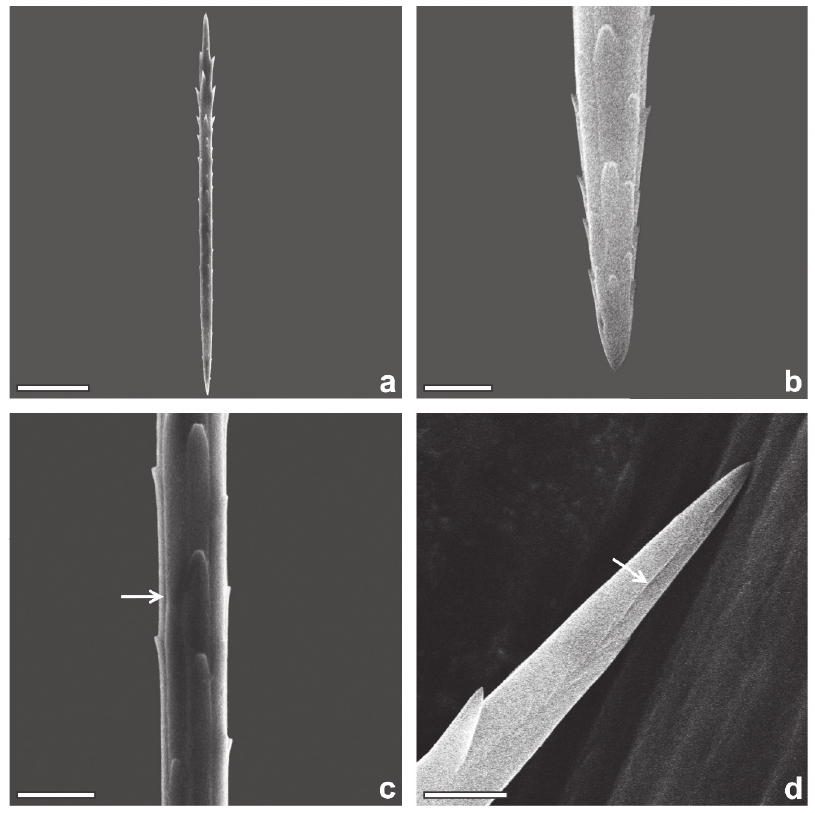
Figure 3 - True setae of the female H. oratex . (a) general view; (b) base; (c) medial portion, arrow indicates a longitudinal groove; (d) apex, arrow indicates the apical groove (scales = 25, 03, 05, 05 µm,